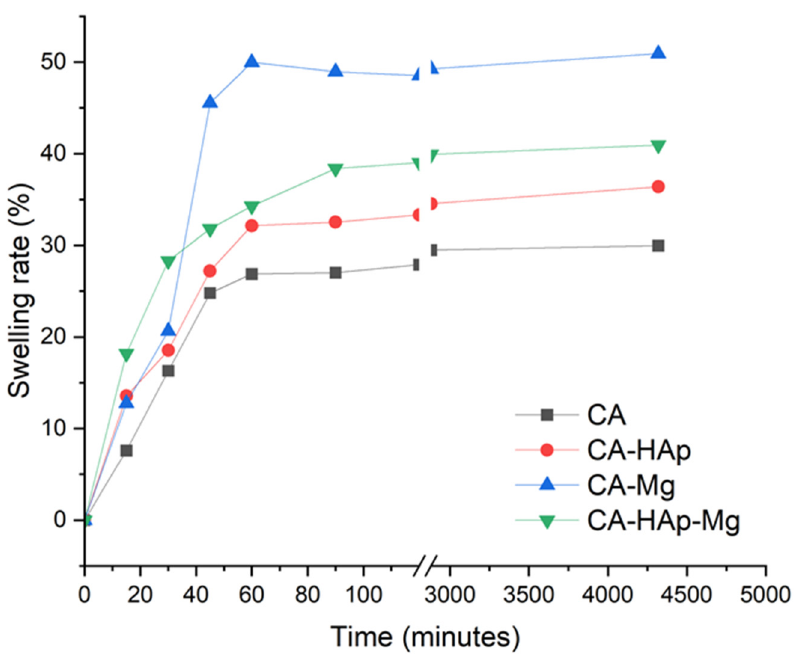
Figure 9. Swelling of the experimental samples over a period of 72 h in PBS solution.